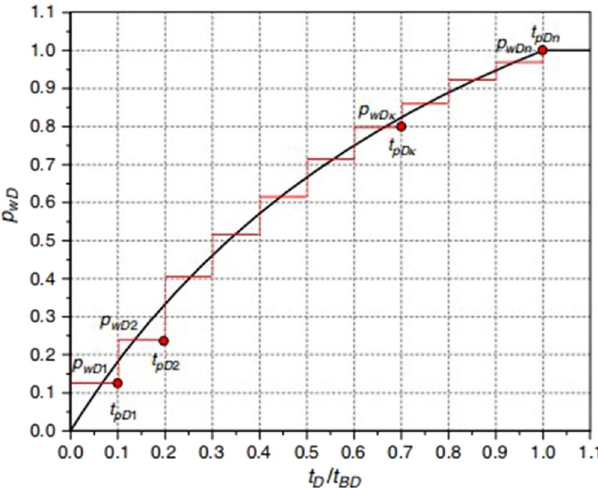
Figure 8. Stepwise schematic of dimensionless BHP drawdown 41